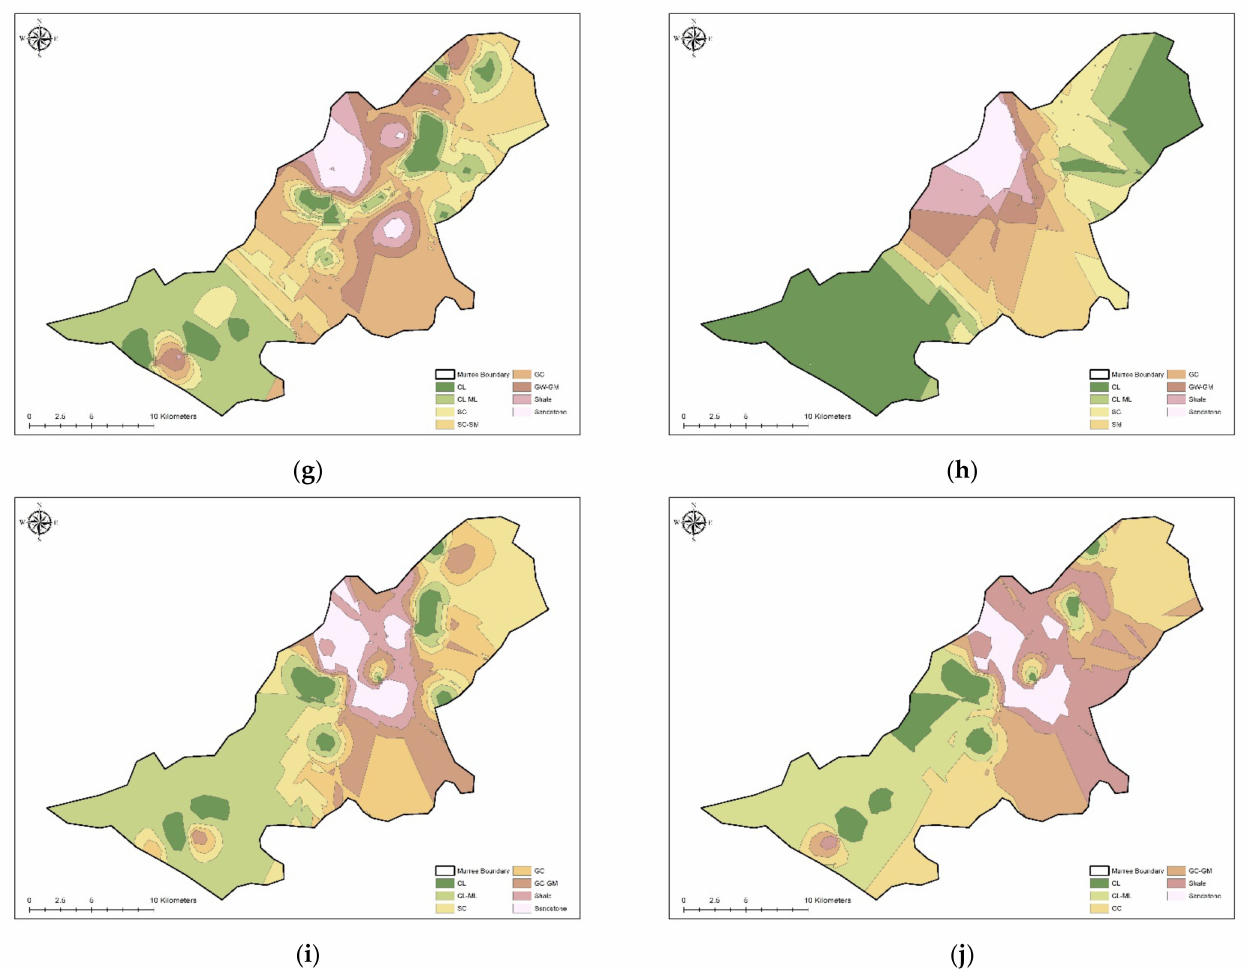
Figure 7. Plasticity maps at ( a ) 1.52 m depth, ( b ) 3.05 m depth, ( c ) 4.57 m depth, ( d ) 6.10 m depth, ( e ) 7.62 m depth and ( f ) 9.14 m depth, ( g ) 10.68 m depth, ( h ) 12.19 m depth and ( i ) 13.72 m depth, ( j ) 15.24